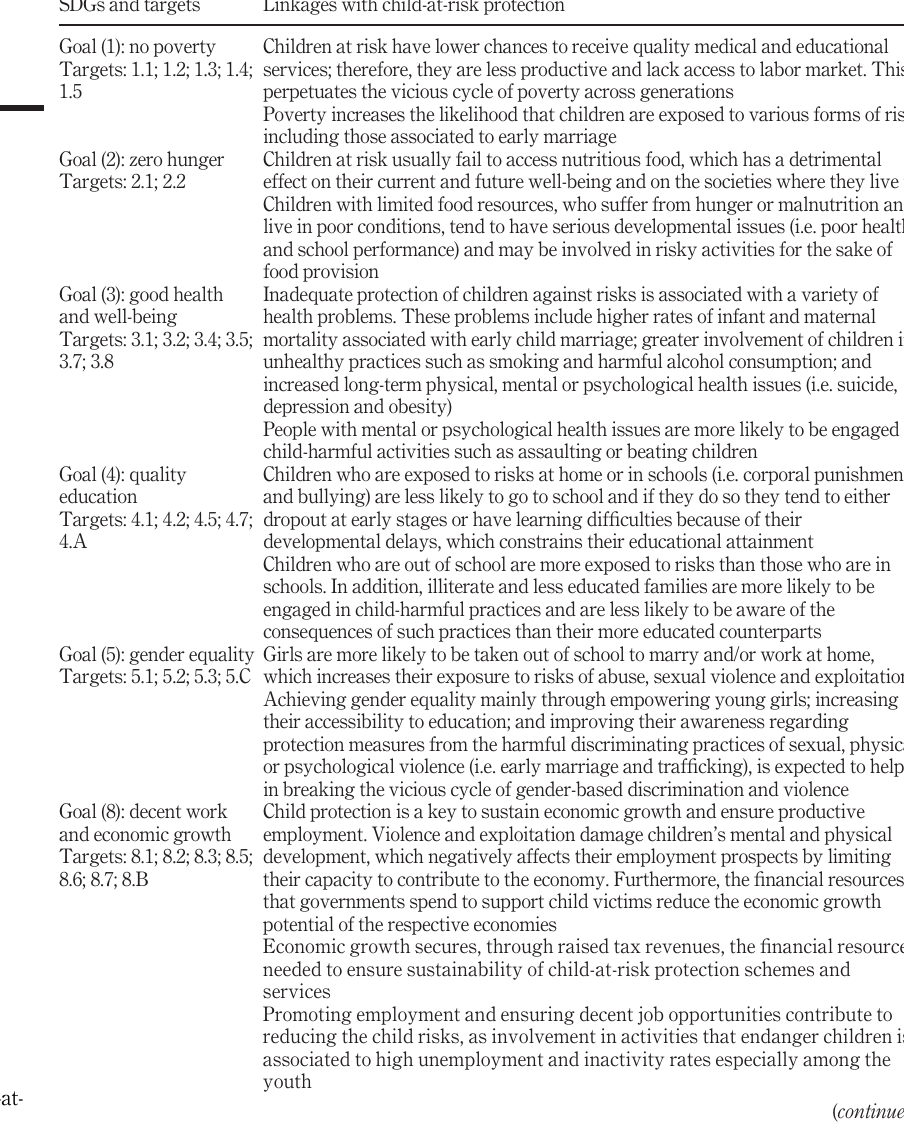
Table A1. SDGs and child-at- risk